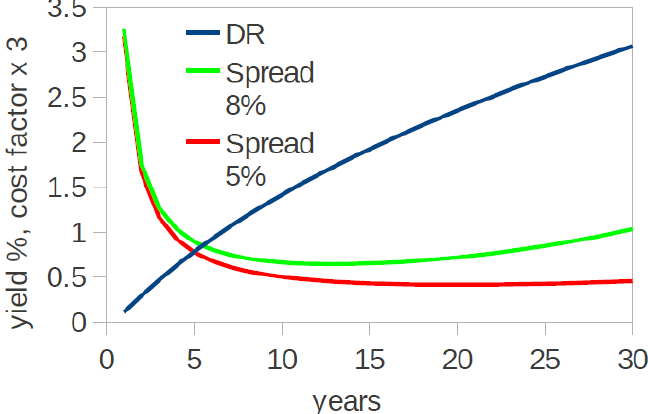
Figure 1. A model US Treasury yield curve (blue) and the cost factor, Equation (6) for the spread over the risk-free rate of 5% (red) and 8% (green). A sample US Treasury yield curve was taken from www.finance.yahoo.com. The equation we used is (cid:1877)(cid:1861)(cid:1857)(cid:1864)(cid:1856), % (cid:3404) 0.0034 (cid:3400) (cid:4666)1.2892(cid:1864)(cid:1866)(cid:4666)(cid:1877)(cid:1857)(cid:1853)(cid:1870)(cid:1871)(cid:4667) (cid:3397) 2.7061(cid:4667) (cid:2871).(cid:2872)(cid:2875)(cid:2871)(cid:2870)(cid:2875)(cid:2870) , which approximates the yield curve as of October 3, 2011.